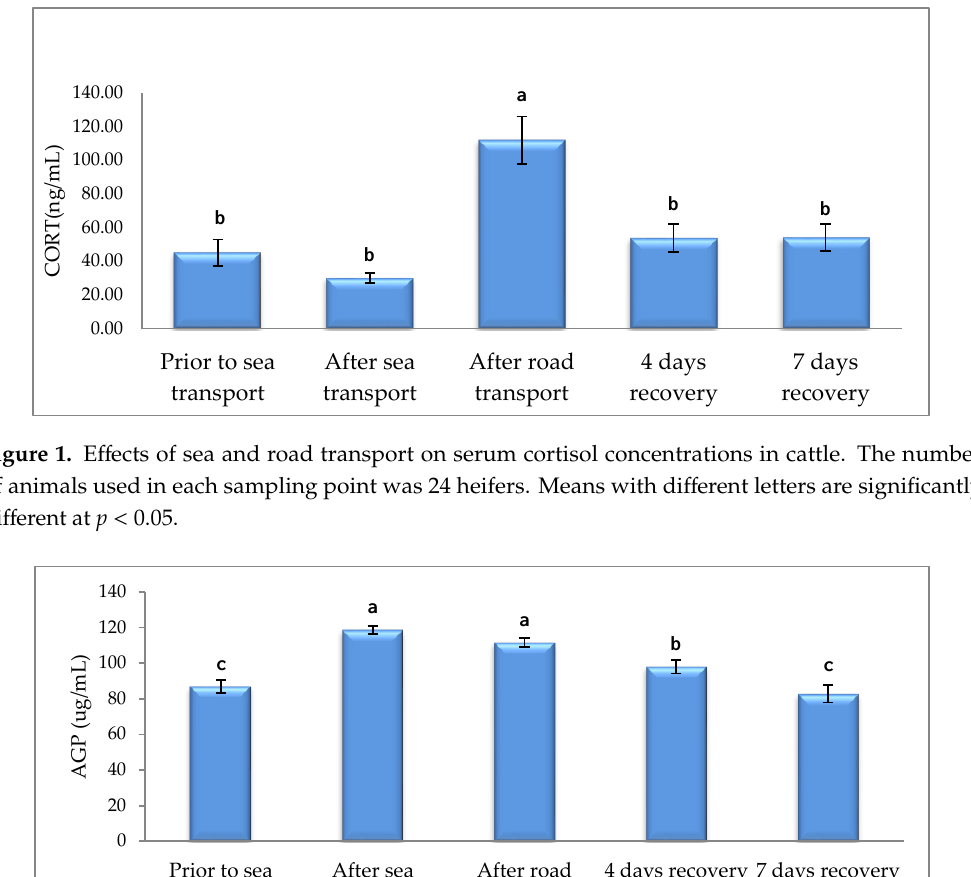
6 of 15 Table 2. Effects of sea and road transport on haematological parameters in cattle (Mean ± SE). Parameter